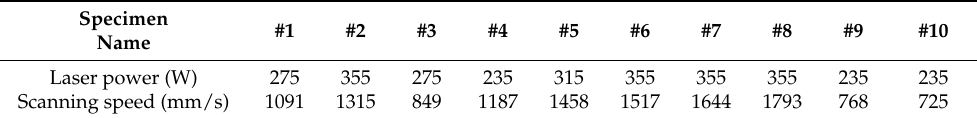
Table 1. Laser power and laser scanning speed used for specimen creation.